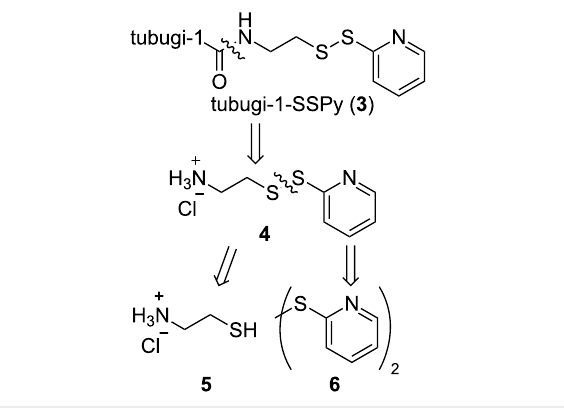
with a tubugi toxin. Therefore, the NPY analogue [K 4 (C- β A-),F 7 ,L 17 ,P 34 ]-hNPY was conjugated with tubugi-1 ( 2 ) as therapeutic payload, using a linker that promises a